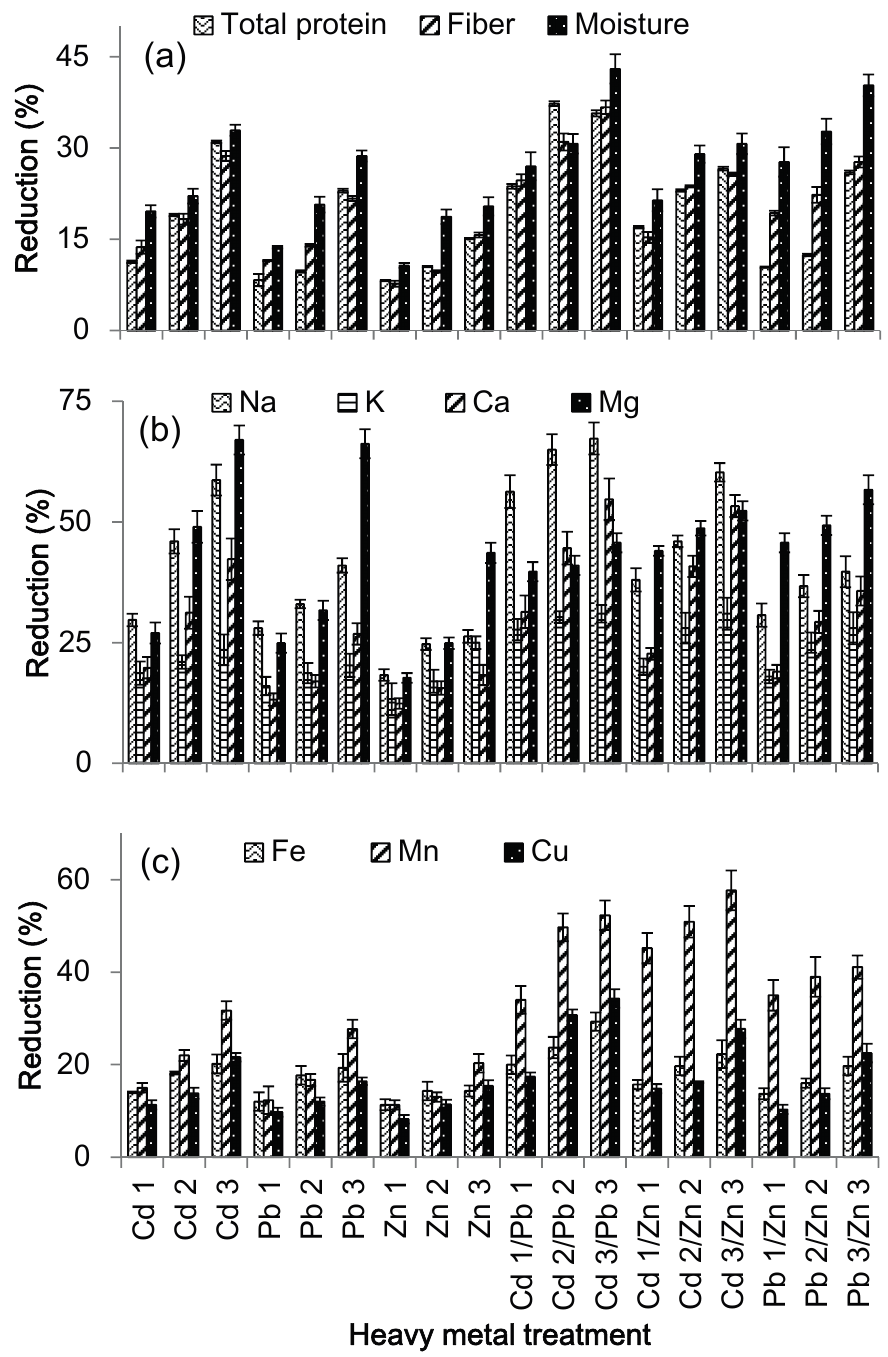
Figure 2. Reduction (%) in ( a ) total protein, total fiber and moisture; ( b ) sodium (Na), potassium (K), calcium (Ca) and magnesium (Mg); and ( c ) of iron (Fe), manganese (Mn) and copper (Cu) determined for Spinach ( Spinacia oleracea ) due to different heavy metal (cadmium (Cd), Pb (lead) and Zn (zinc)) treatments (in comparison to the